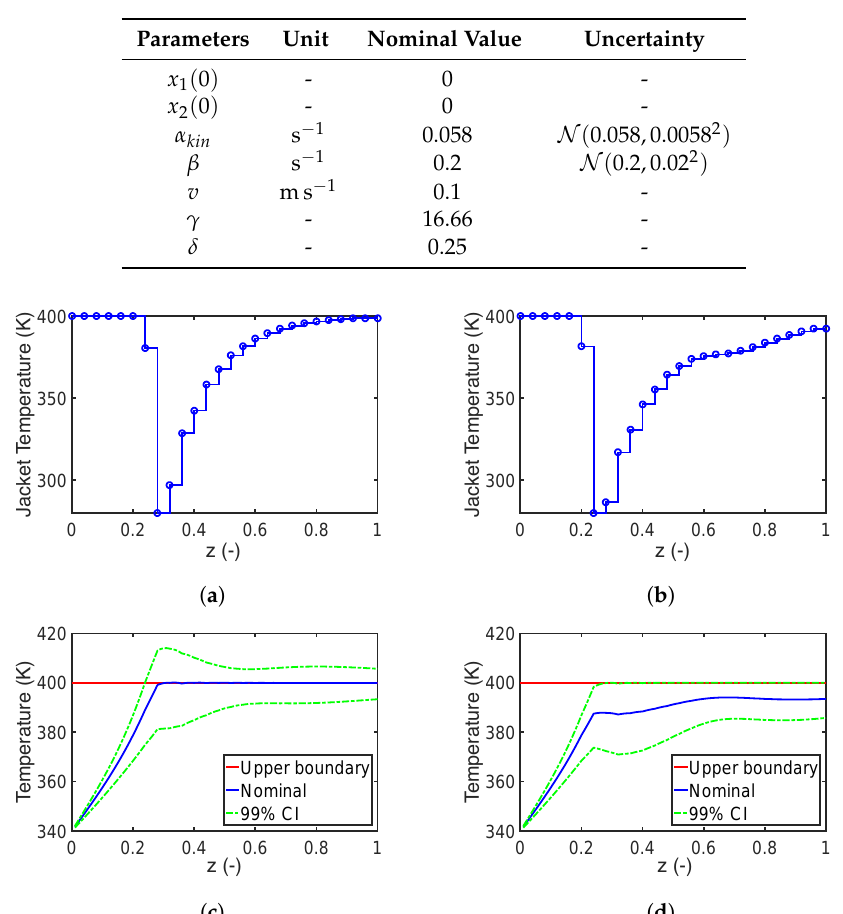
Table 1. Parameters for the tubular reactor model.